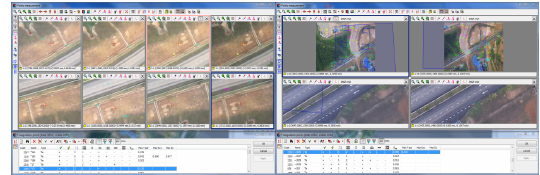
Figure 2. An Example of Tie Point Measurements